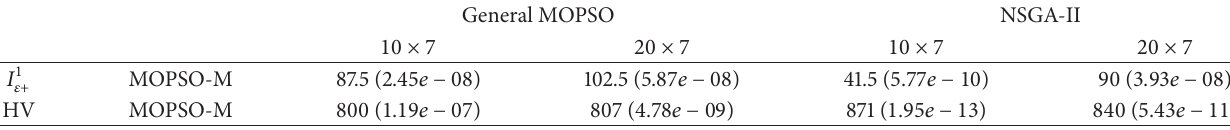
Table 5: Results of the Wilcoxon rank-sum test for the 𝐼 1 𝜀+ and HV indicators.